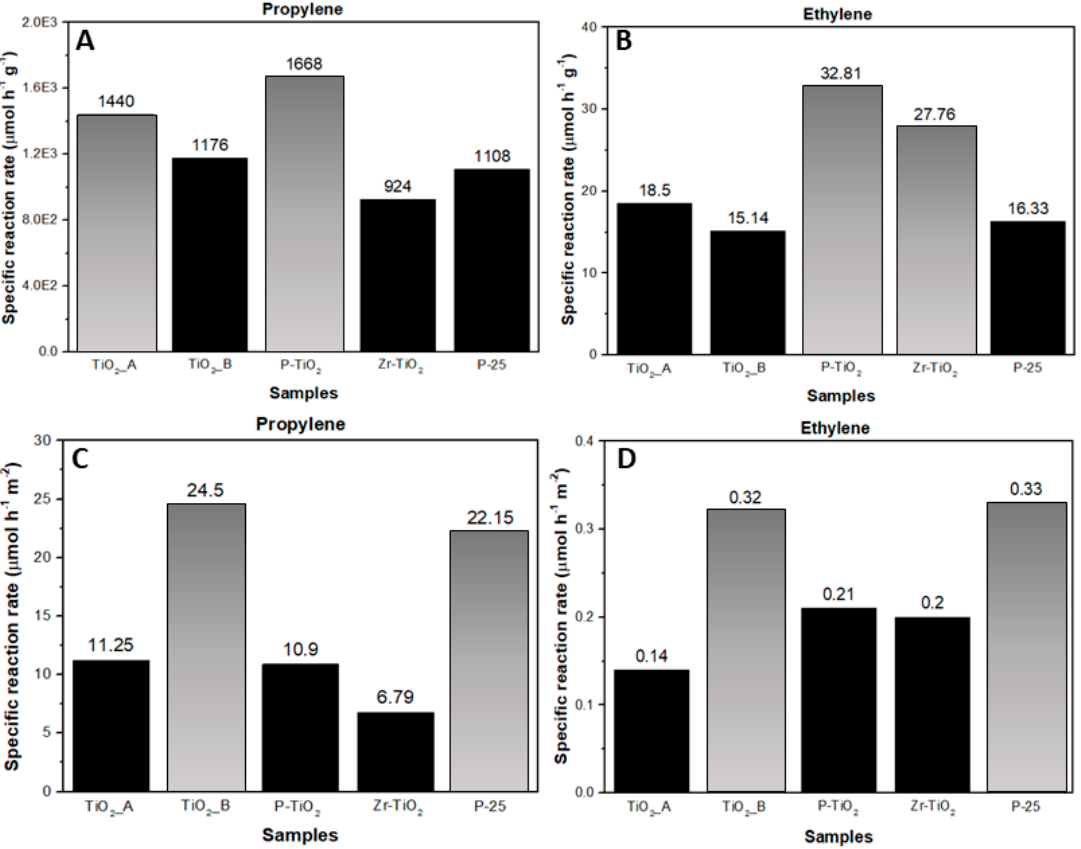
Figure 11. Specific reaction rates of the catalysts for the propylene ( A , C ) and ethylene ( B , D ) oxidation reactions.